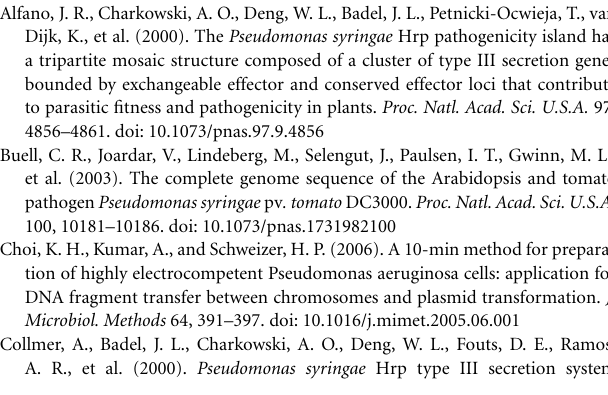
Supplementary Table 1 | Peptides and transitions used for MRM-MS. Shown are the charge/mass ratios of the precursor and product ions, chromatographic retention times, parent protein, the peptide sequences and transition IDs, specifying if derived from the analyte (a) or internal standard (IS) as well as the used collision energies in Q2. ∗ , not used as histidine tagged (see text). Supplementary Figure 1 | Fluorescence image (A) and lane evaluation (B) of SYPRO ruby stained SDS Page of isotopic labeled HrpA1 and AvrPto1 protein standards. Purities were estimated by band intensities of the expected SDS Page gel mobilities of 18329 Da (AvrPto1) and 11387 (HrpA1) relative to total protein intensities. Supplementary Figure 2 | Growth curves of DC 3000 in HIM-fructose media at pH 5.5 (blue), 6 (red) and 6.5 (green), as judged by optical density at 600nm (OD 600 ). At 48h, cells had entered early stationary phase as judged by slowing